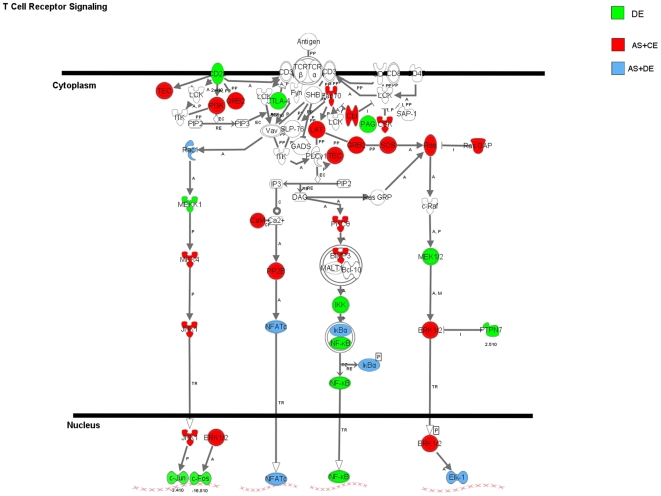
T cell receptor signaling pathway is populated by members from all three classes of genes during activation.Schematic diagram represents the T cell receptor signaling pathway populated by the Ingenuity Pathway Analysis using genes assigned to all three classes detected throughout the time course of activation. Shapes in green represent the class of genes with differential expression without alternative splicing (DE). Shapes in red represent the class of genes that are alternatively spliced with constitutive gene expression (AS+CE). Shapes in blue represent genes both alternatively spliced and differentially expressed (AS+DE). Legend for Ingenuity-Mapped Interactions: A  =  Activation, C  =  Causes/Leads to, CP  =  Chemical-Protein Interaction, EC  =  Enzyme Catalysis, I  =  Inhibition, M  =  Biochemical Modification, P  =  Phosphorylation/Dephosphorylation, PP  =  Protein-Protein binding, RE  =  Reaction, TR  =  Translocation. An arrow pointing from A to B signifies that A causes B to be activated.